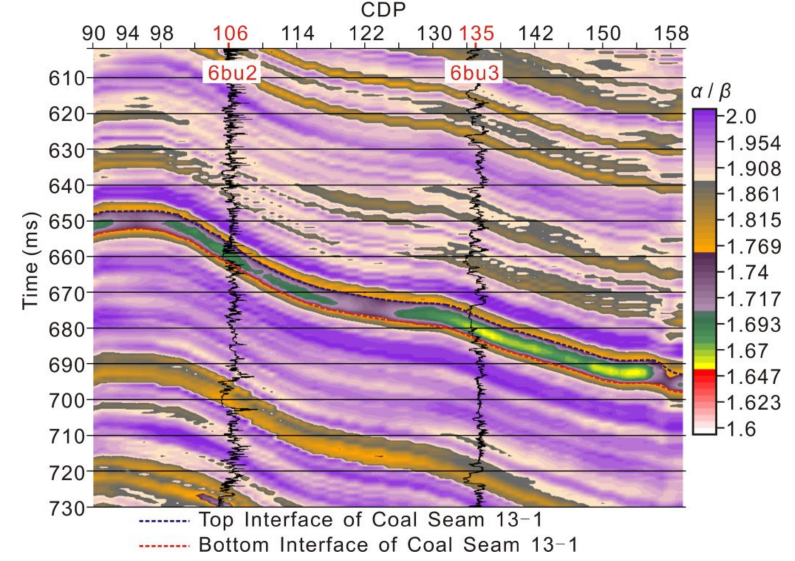
Figure 10. Inverted P- to S-wave velocity ratio section across wells 6bu2 and 6bu3 at line 341.